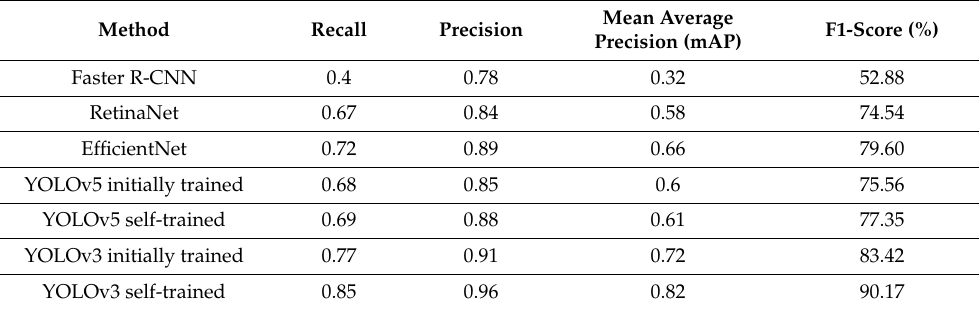
Table 2. Overall training evaluation metrics (best result in bold) for a single UAS image for 30% of the input data (1900 test samples out of 6100 images in total).